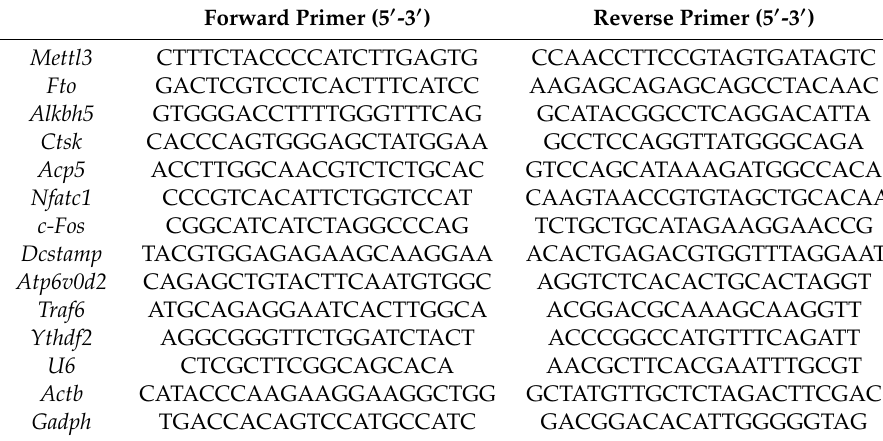
Table 3. Sequences for